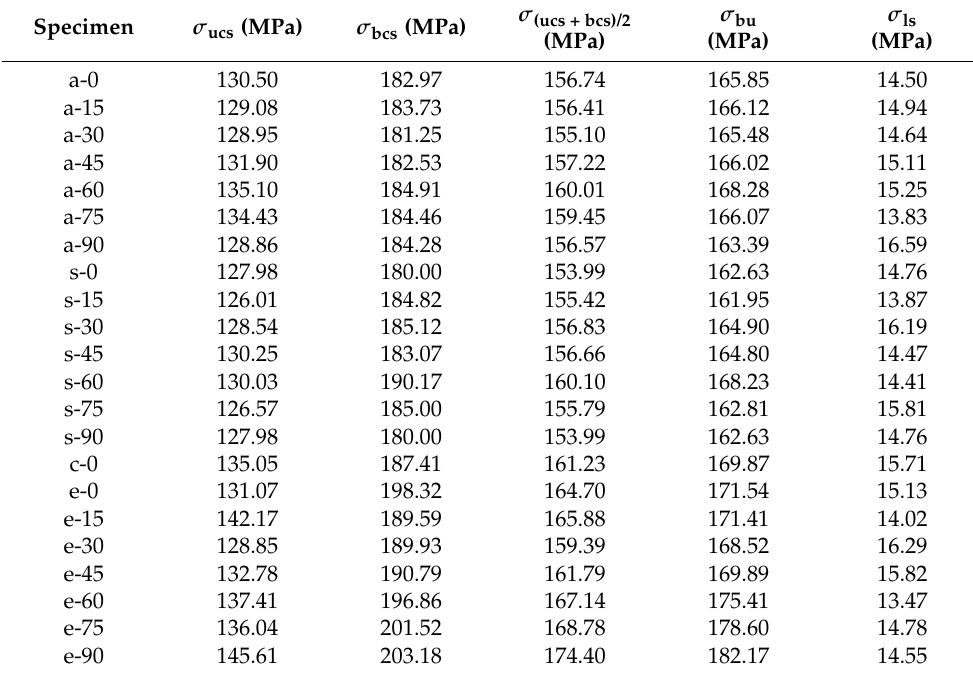
Table 3. Strength parameters of numerical specimens containing different prefabricated